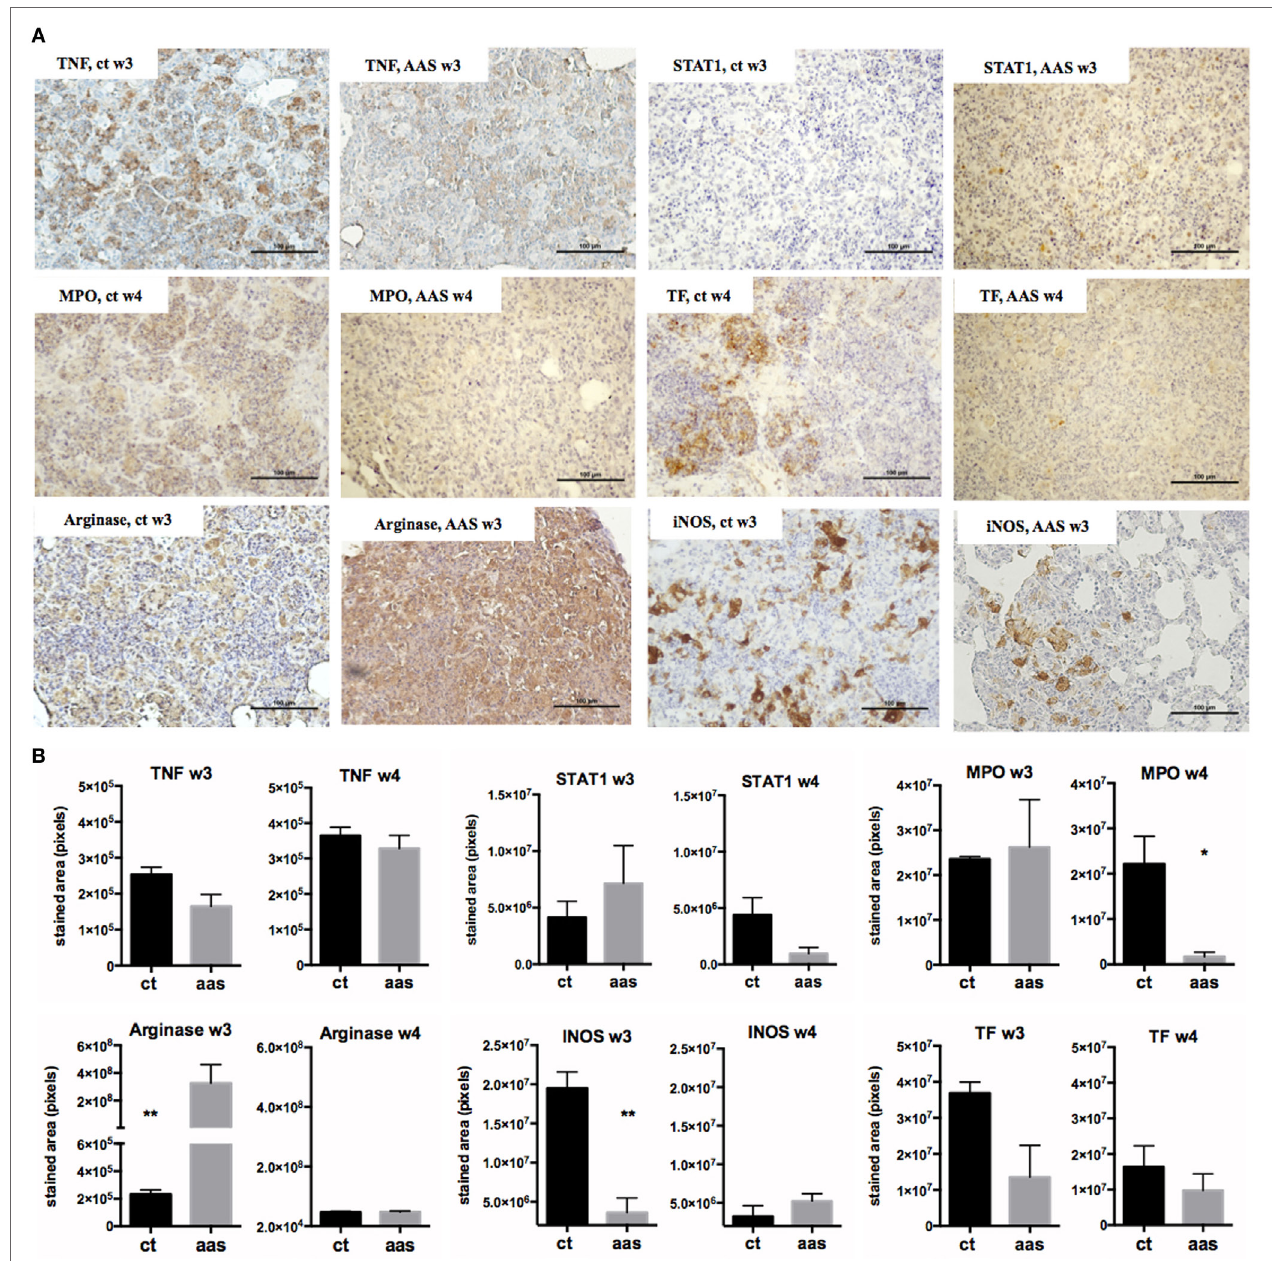
FigUre 4 | Impact of AAS in lung measured by IHQ. Panel (a) shows some pictures of the staining. The bar represents 100 µm. Panel (B) shows the results of the staining quantification by experimental group and timepoint. Abbreviations: AAS, aspirin; TNF, tumor necrosis α ; STAT1, signal transducer and activator of transcription 1; MPO, myeloperoxidase; INOS, inducible nitric oxide synthase; TF, tissue